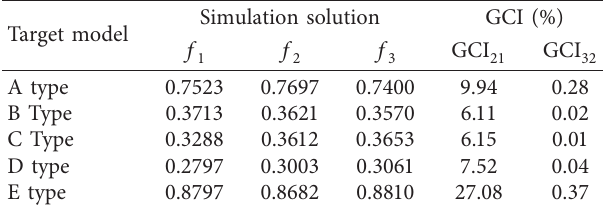
Table 7: Result of GCI